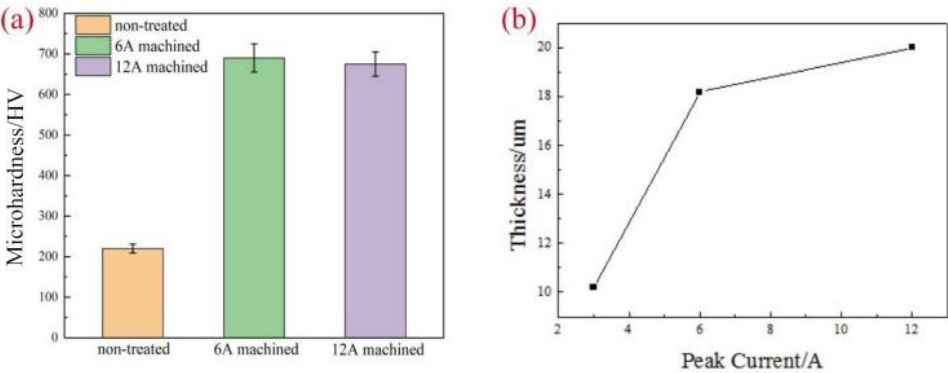
Figure 3. Micro hardness ( a ) and thickness ( b ) of modified layer with different peak current. To assess the wettability of the modified layers, the contact angle of 3.5 wt.% sodium chloride drops deposited onto the surface of all samples was measured by an optical contact angle meter (SD-CAZ2, Shengding Precision Instrument Co., Ltd., Dongguan,